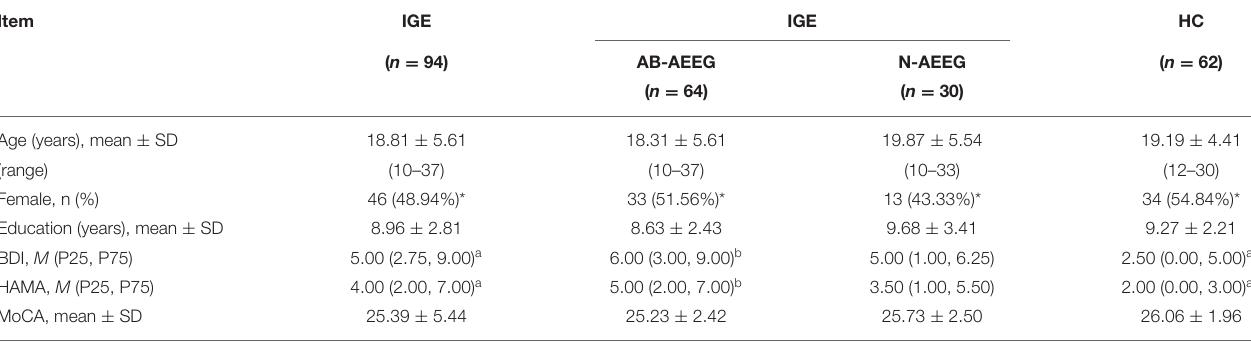
TABLE 1 | Demographic and clinical characteristics of the participants.